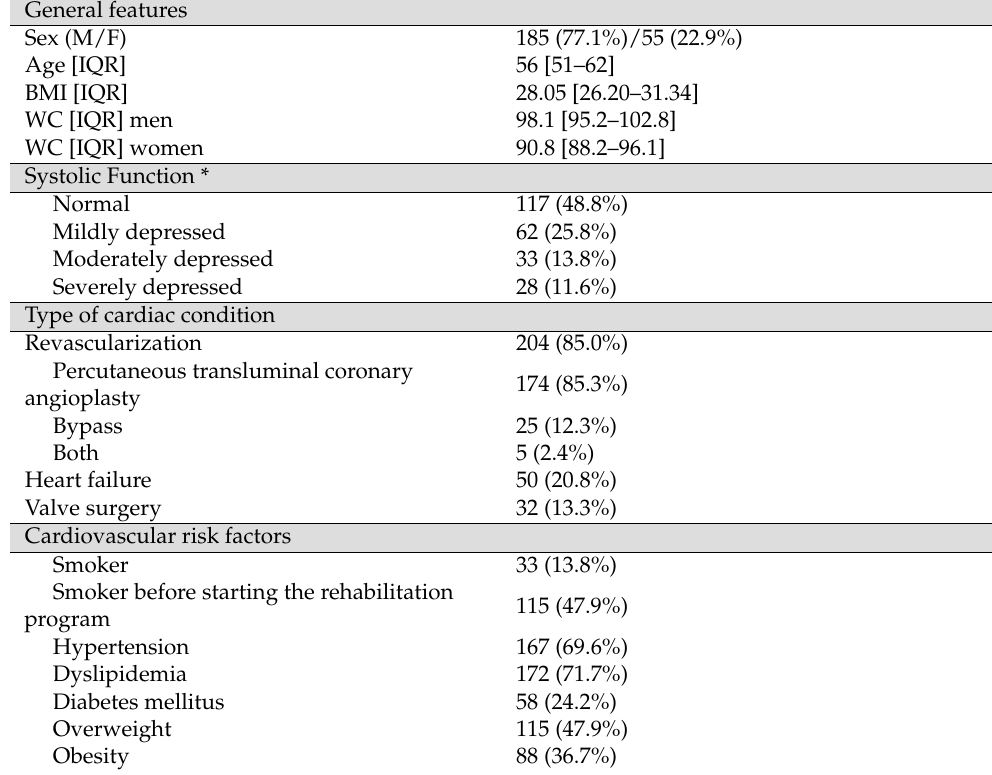
Table 1. Physical characteristics, type of cardiac condition and Cardiovascular Risk